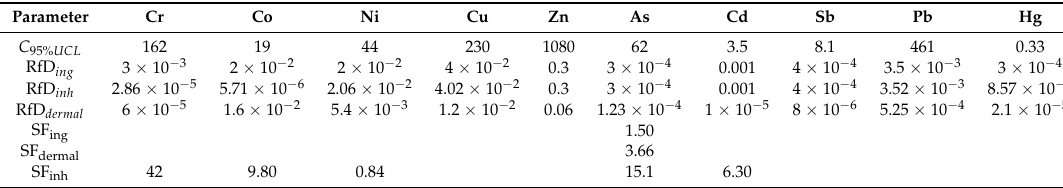
Table 2. 95% UCL (mg kg − 1 ) of heavy metal(loid)s in streets of Hezhang city and the RfD (mg kg − 1 day − 1 ) and SF (mg kg − 1 day − 1